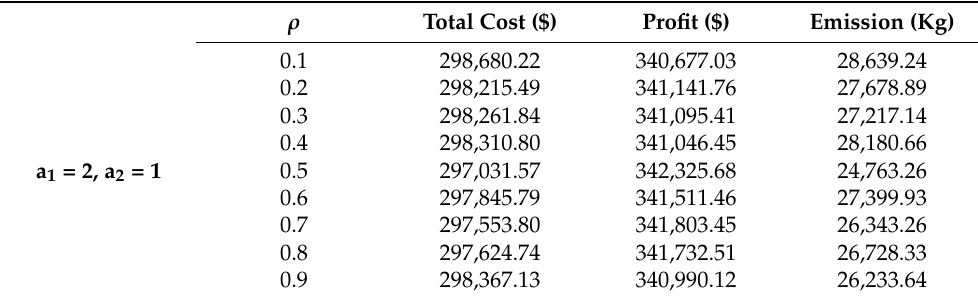
Table 3. Best Compromise Solution with variation of generation probability ‘ ρ ’ for Test Case 4 (a 1 = 2 and a 2 = 1).